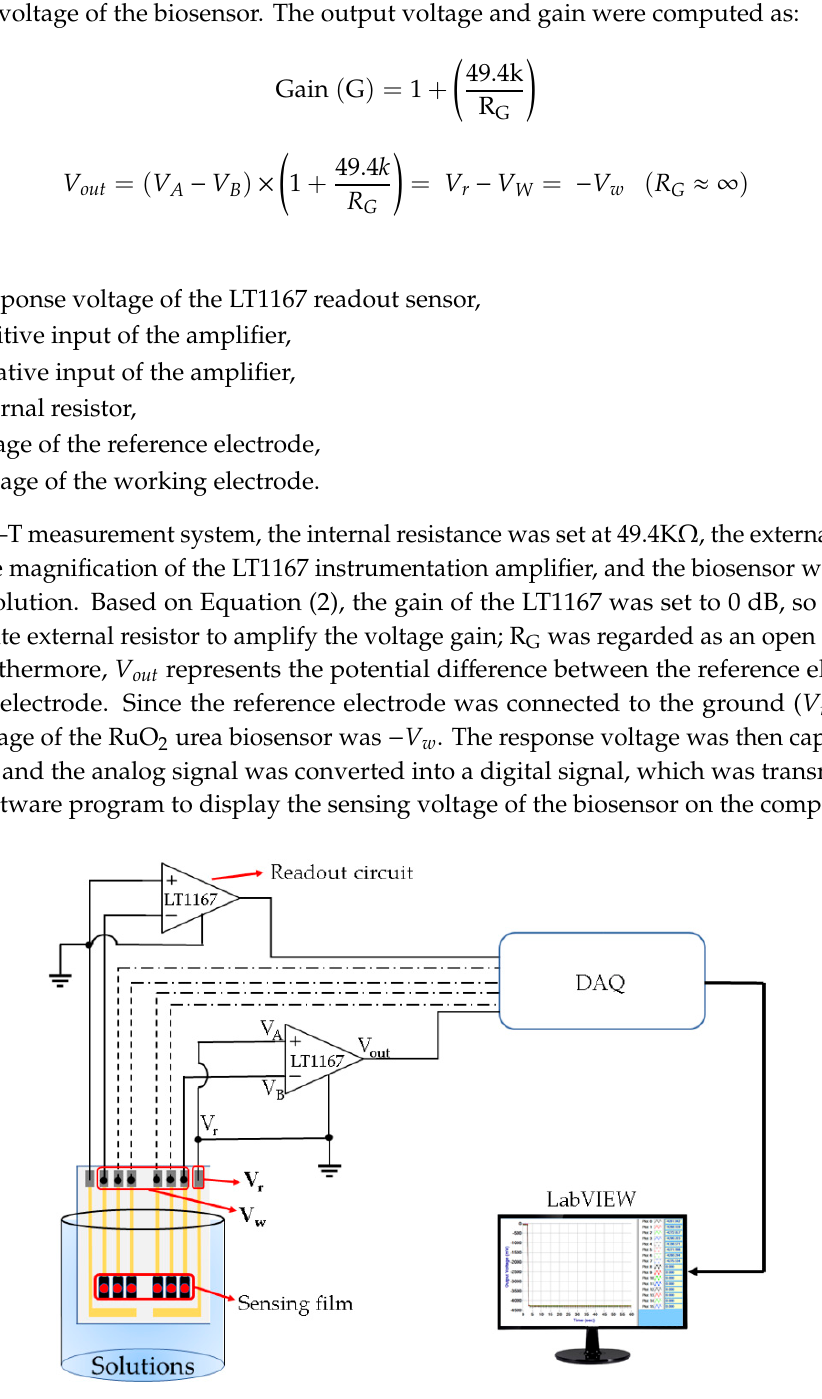
Figure 2. The schematic diagram of the traditional V–T measurement system [32].